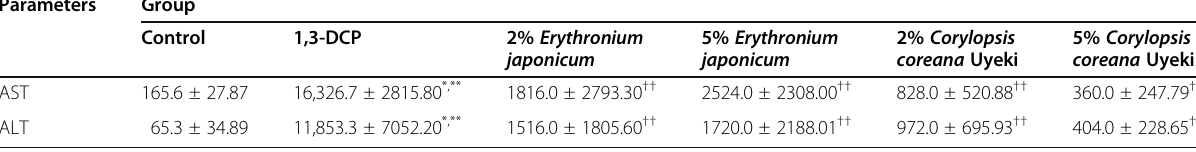
Table 2 Effects of test materials on serum aspartate aminotransferase (AST) and alanine aminotransferase (ALT) activities in rats Parameters